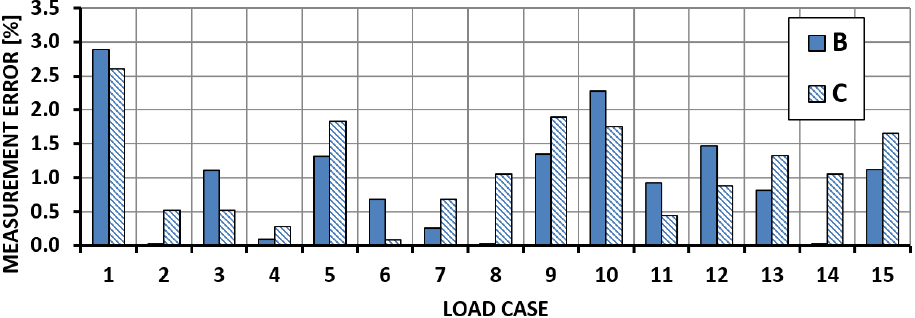
Figure 14. Bending moment measurement error—OPT Section.